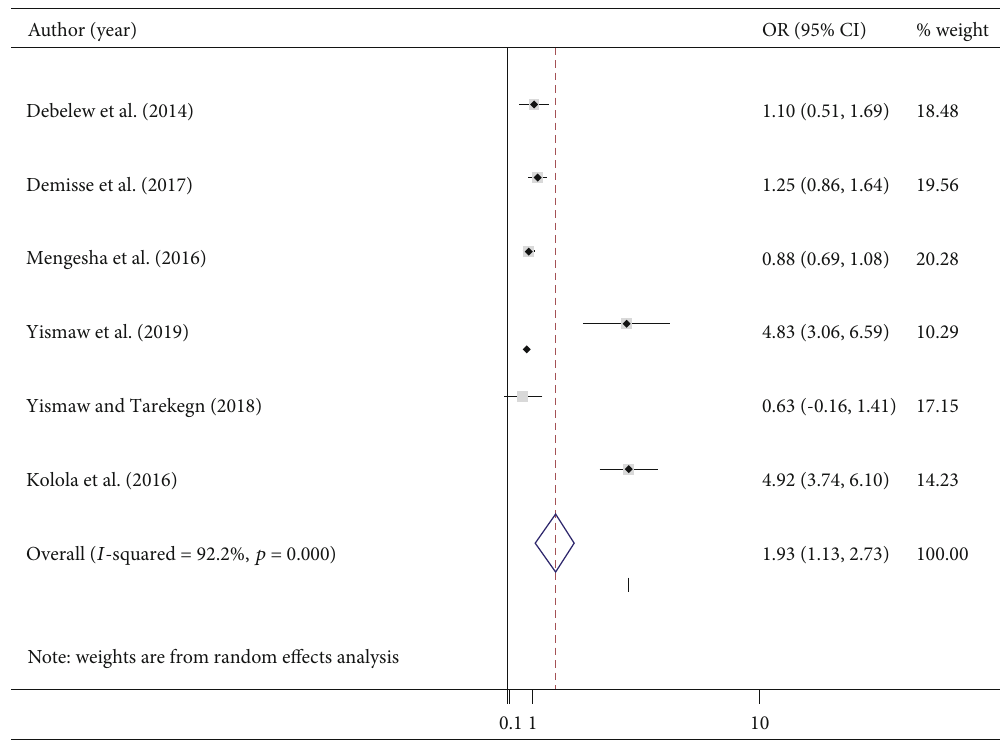
Figure 5: The pooled odds ratio of the association between residency and neonatal